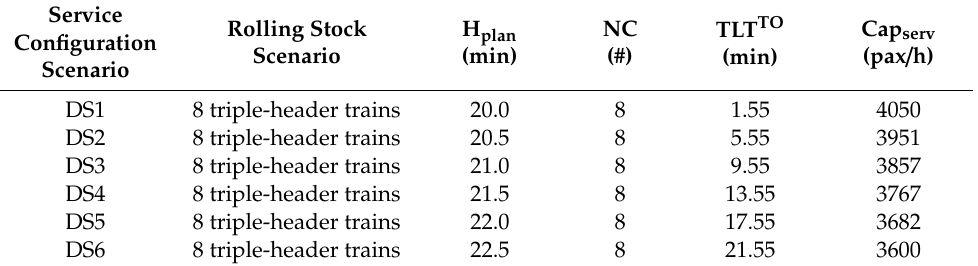
Table 7. Service configurations implementable in disrupted